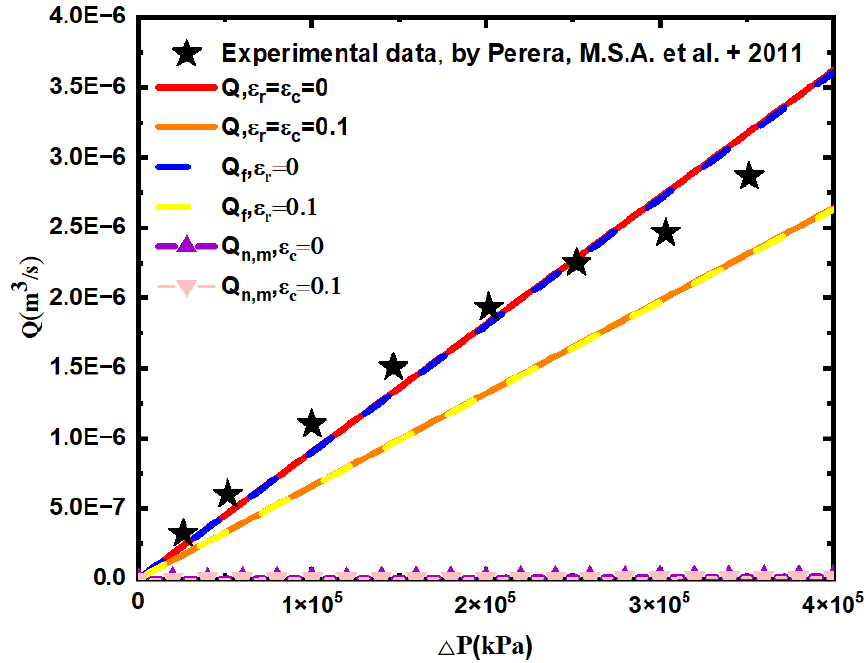
Figure 11. Comparison of predicted and experimental data [52] of Newtonian fluid flow at 25 ◦ C temperature and 500 kPa confining pressure.